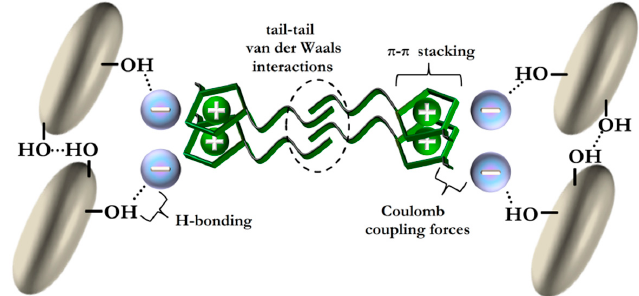
Figure 4. Schematic representation of H-bond “co- π - π stacking” mechanism and the possible interactions among silica and ILs [61] (permission obtained for reproduction).